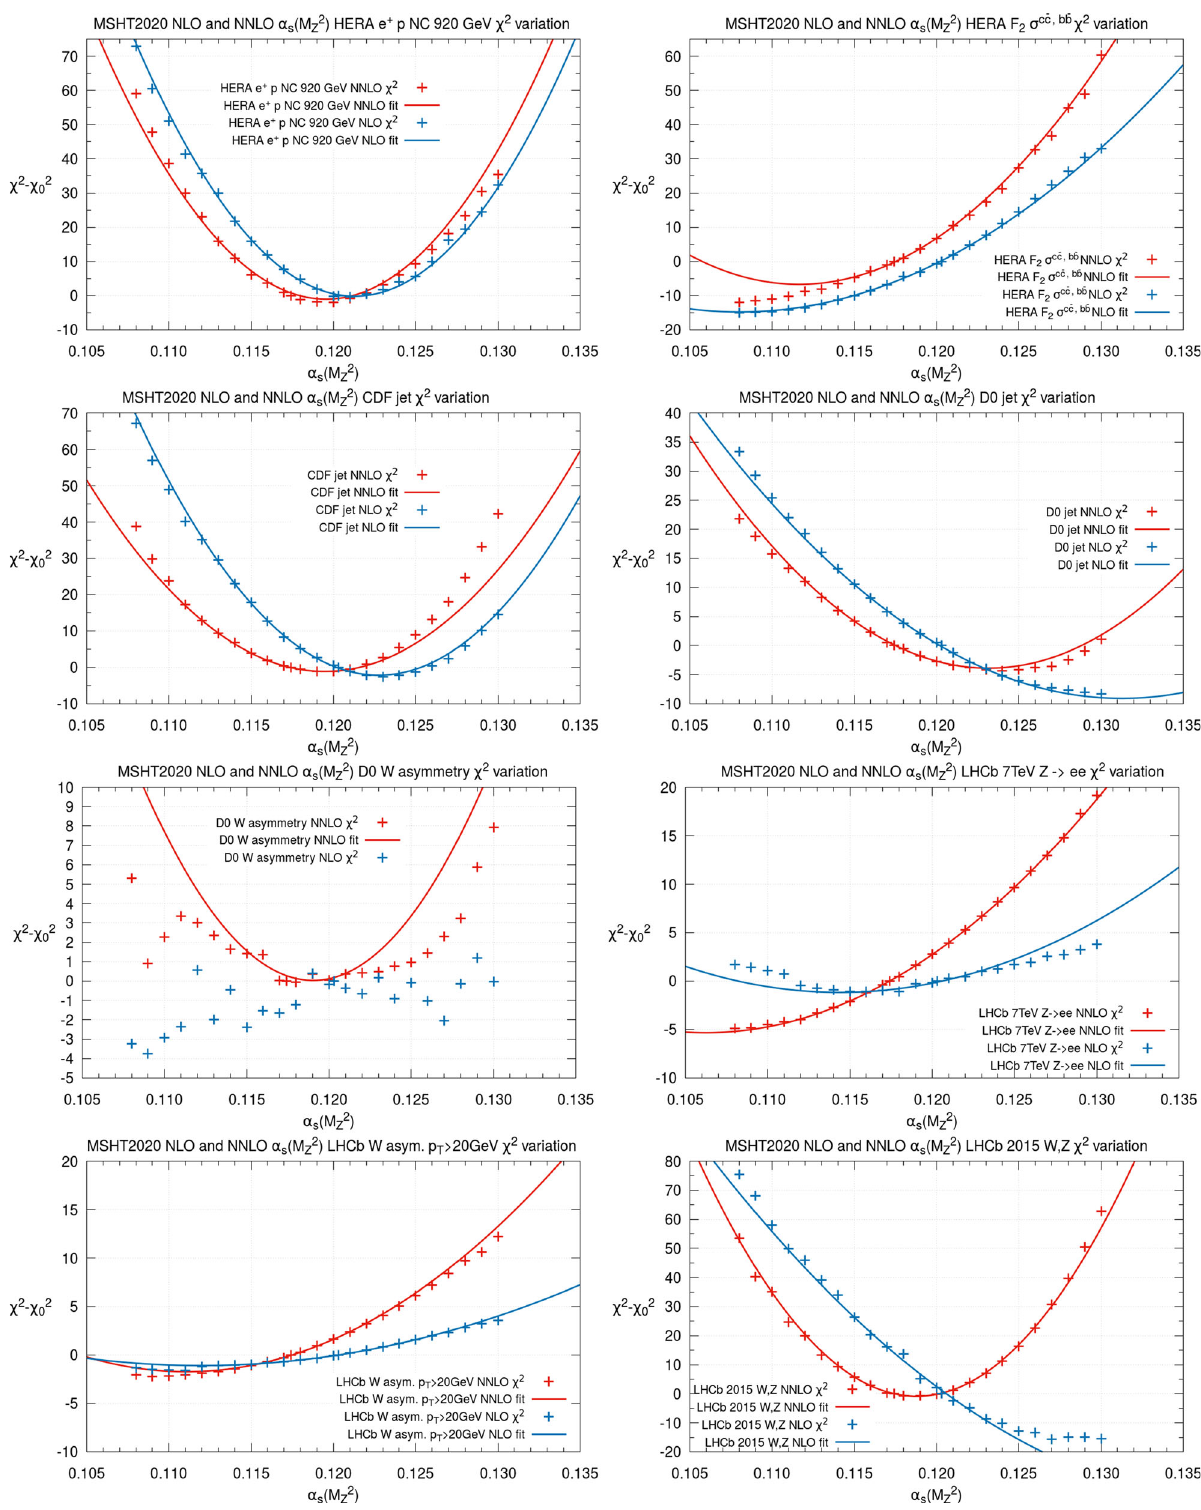
Fig. 3 Difference in the χ 2 relative to the χ 2 ) , as a function of the value of α best fit α S ( M 2 Z (blue) and NNLO (red) MSHT20 fits, respectively. The points are the results of the fits at a variety of fixed α S ( M 2